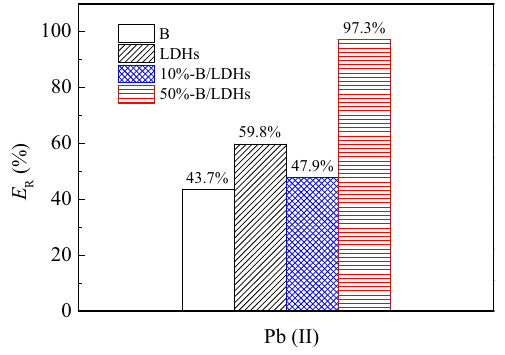
= 0.010 M, 25°C, pH 6.0. The dots 3